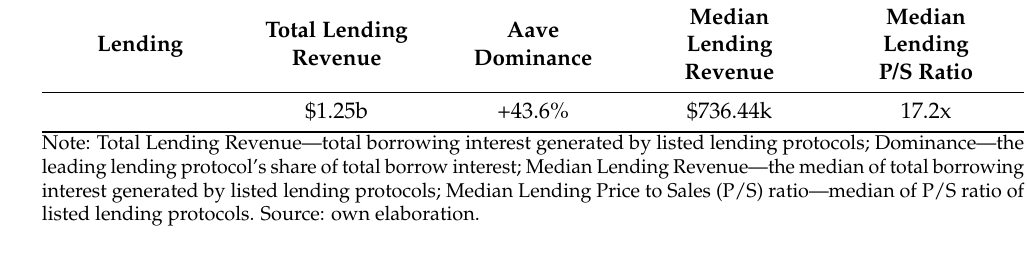
Table 4. Descriptive statistics for the decentralized exchanges class of tokens. Exchange